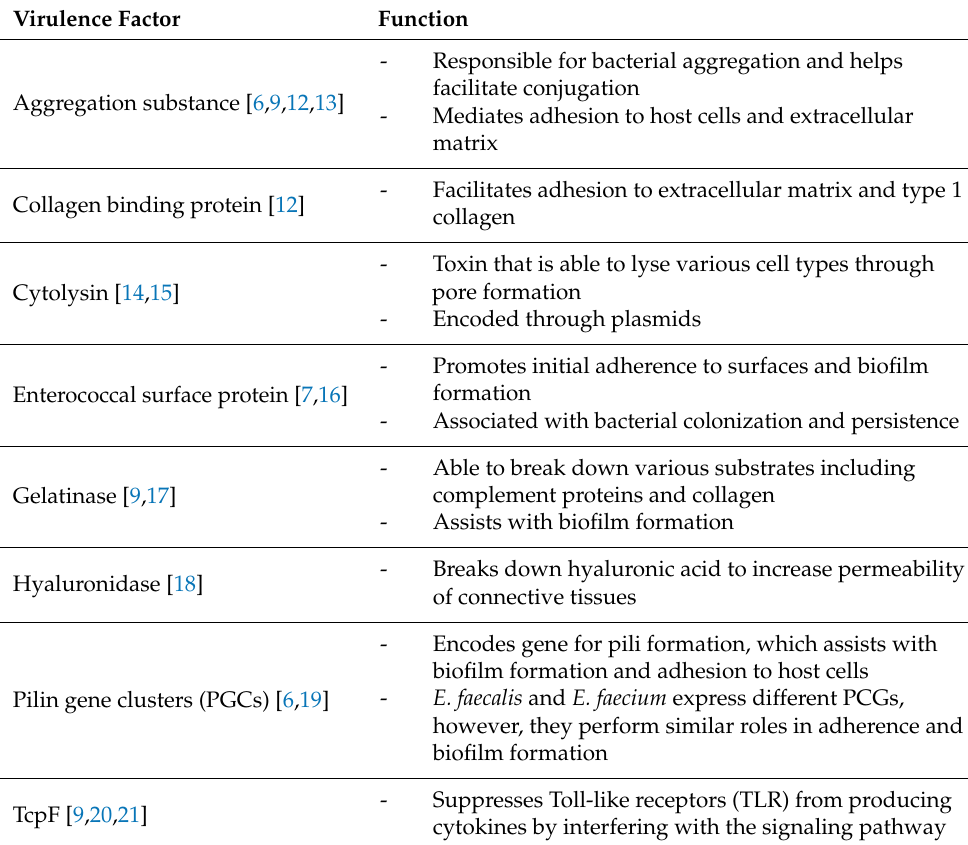
Table 1. Known virulence factors of